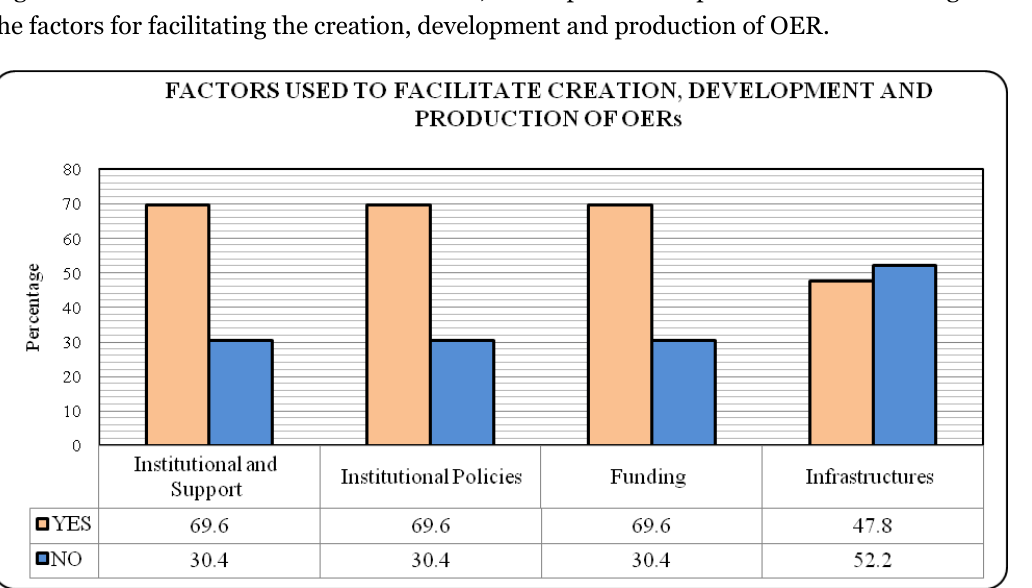
Figure 6. Factors for facilitating creation, development and production of